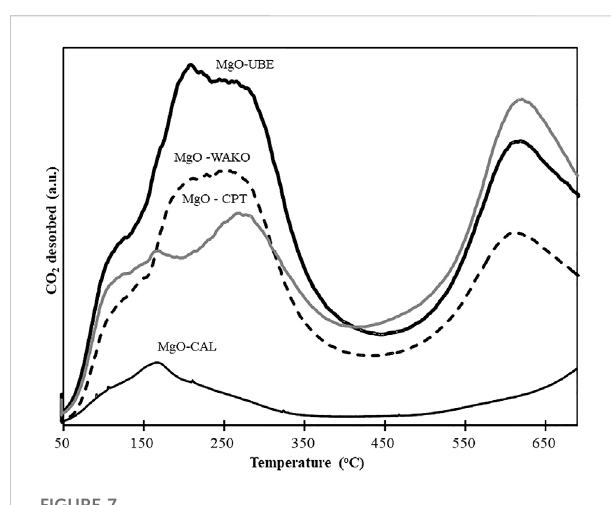
FIGURE 7 CO 2 -TPD pro fi les of different MgO